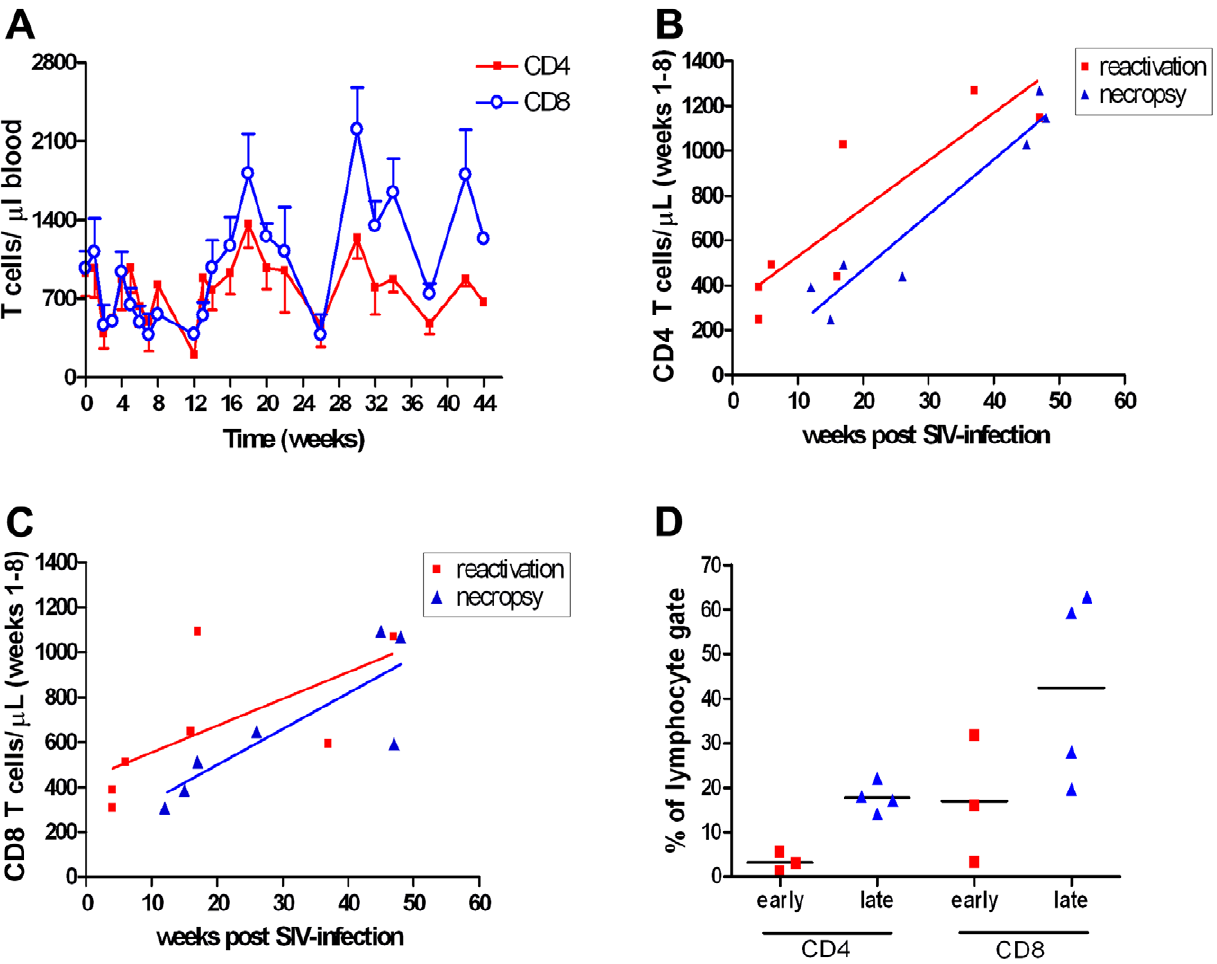
Figure 2. Acute CD4 T cell depletion correlates with reactivated TB. A. Mean CD4 and CD8 T cell numbers from whole blood of co-infected macaques. Upper (CD8) and lower (CD4) error bars have been omitted for clarity. B. Mean CD4 T cell numbers over weeks 1–8 correlate with reactivation (red line: P=0.011, R2=0.756) and necropsy time (blue line: P=0.0007, R2=0.9172). C. Mean CD8 T cell numbers do not correlate with reactivation (red line: P=0.112, R2=0.426) but do correlate to necropsy time (blue line: P=0.020, R2=0.692). D. Animals that reactivate , 17 weeks post-SIV infection have a trend toward lower frequencies of CD4 T cell in the BAL at 10 weeks post SIV infection than monkeys . 26 weeks post SIV infection Man-Whitney (P=0.057). 1207 (early) BAL cells were sampled 8 weeks post SIV